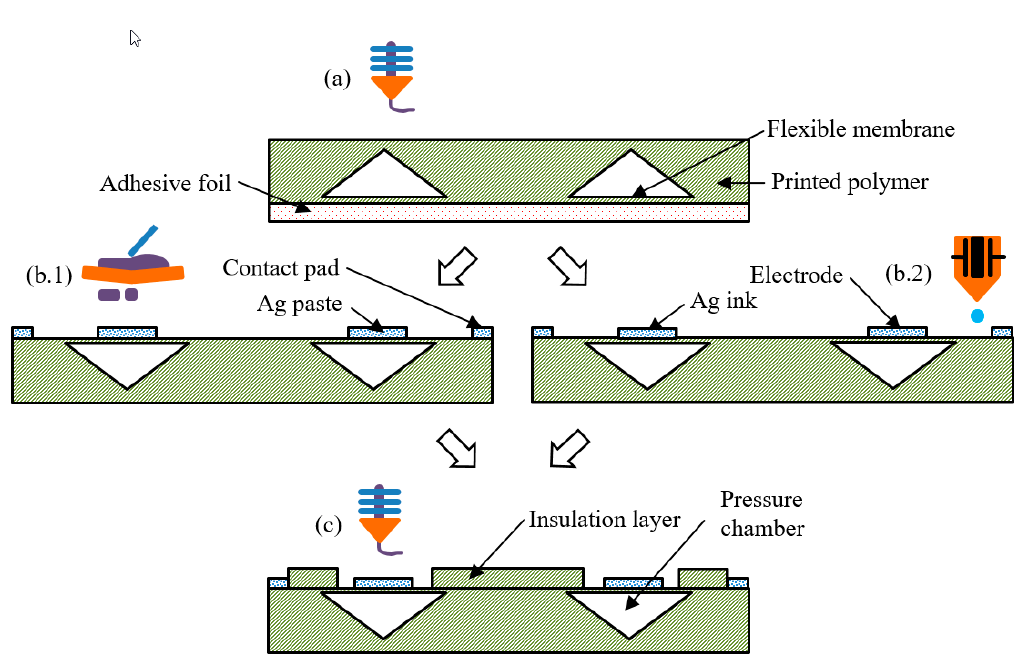
Figure 2. Process steps for printing of the module. ( a ) FDM printing of the basic module; ( b ) Printing of the conductive electrode, ( b.1 ) Screen printing of silver paste, ( b.2 ) Inkjet-printing of silver ink; ( c ) FDM Printing of the insulation layer.